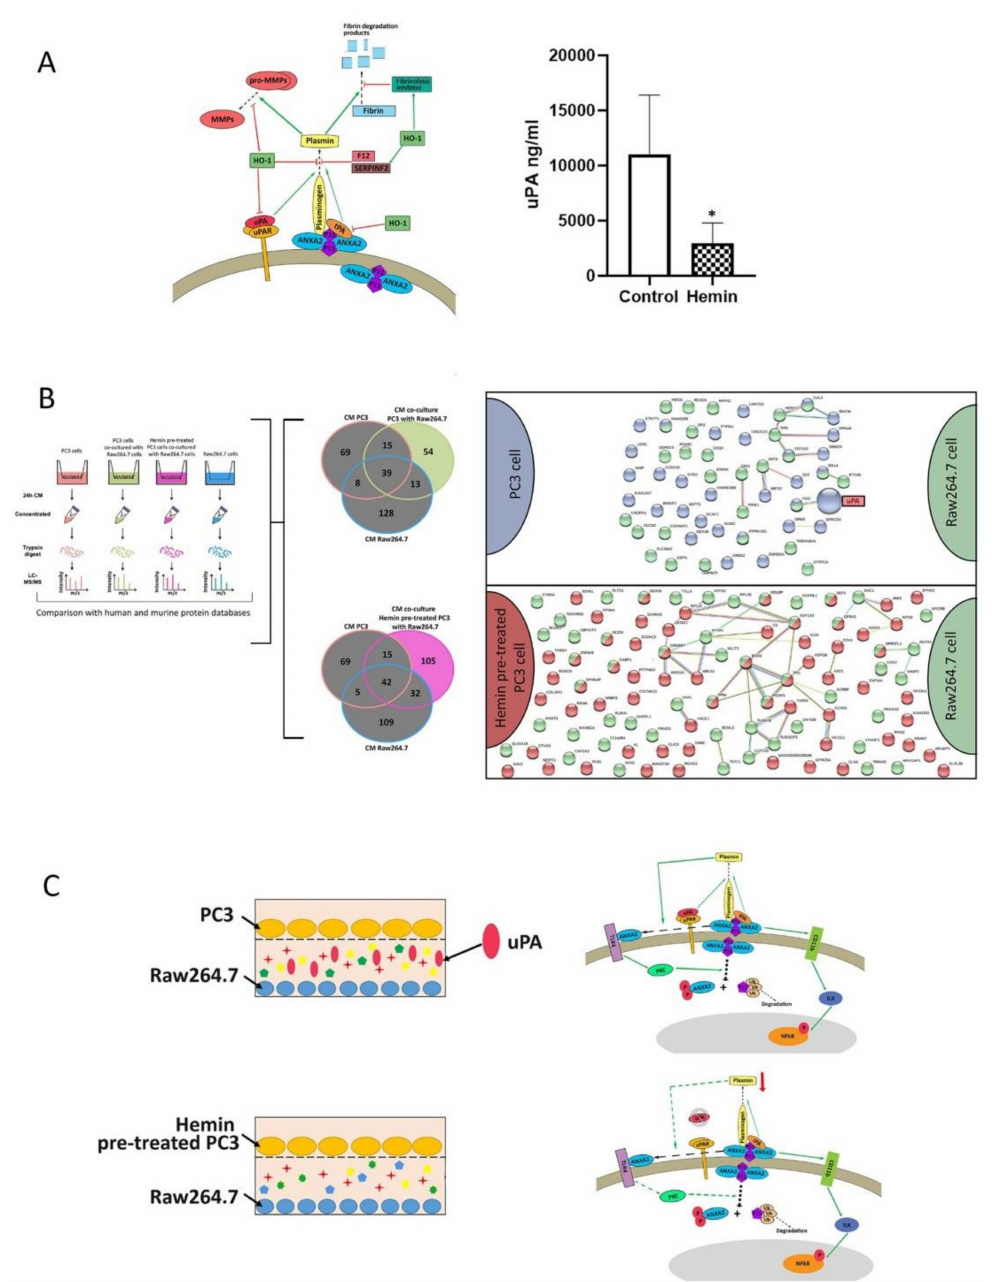
Figure 3. Secretome analyses of conditioned media (CM) from the co-culture transwell system between PC3 and Raw246.t cells. E ff ect of HO-1 induction. ( A ) Model of plasmin regulation by cell